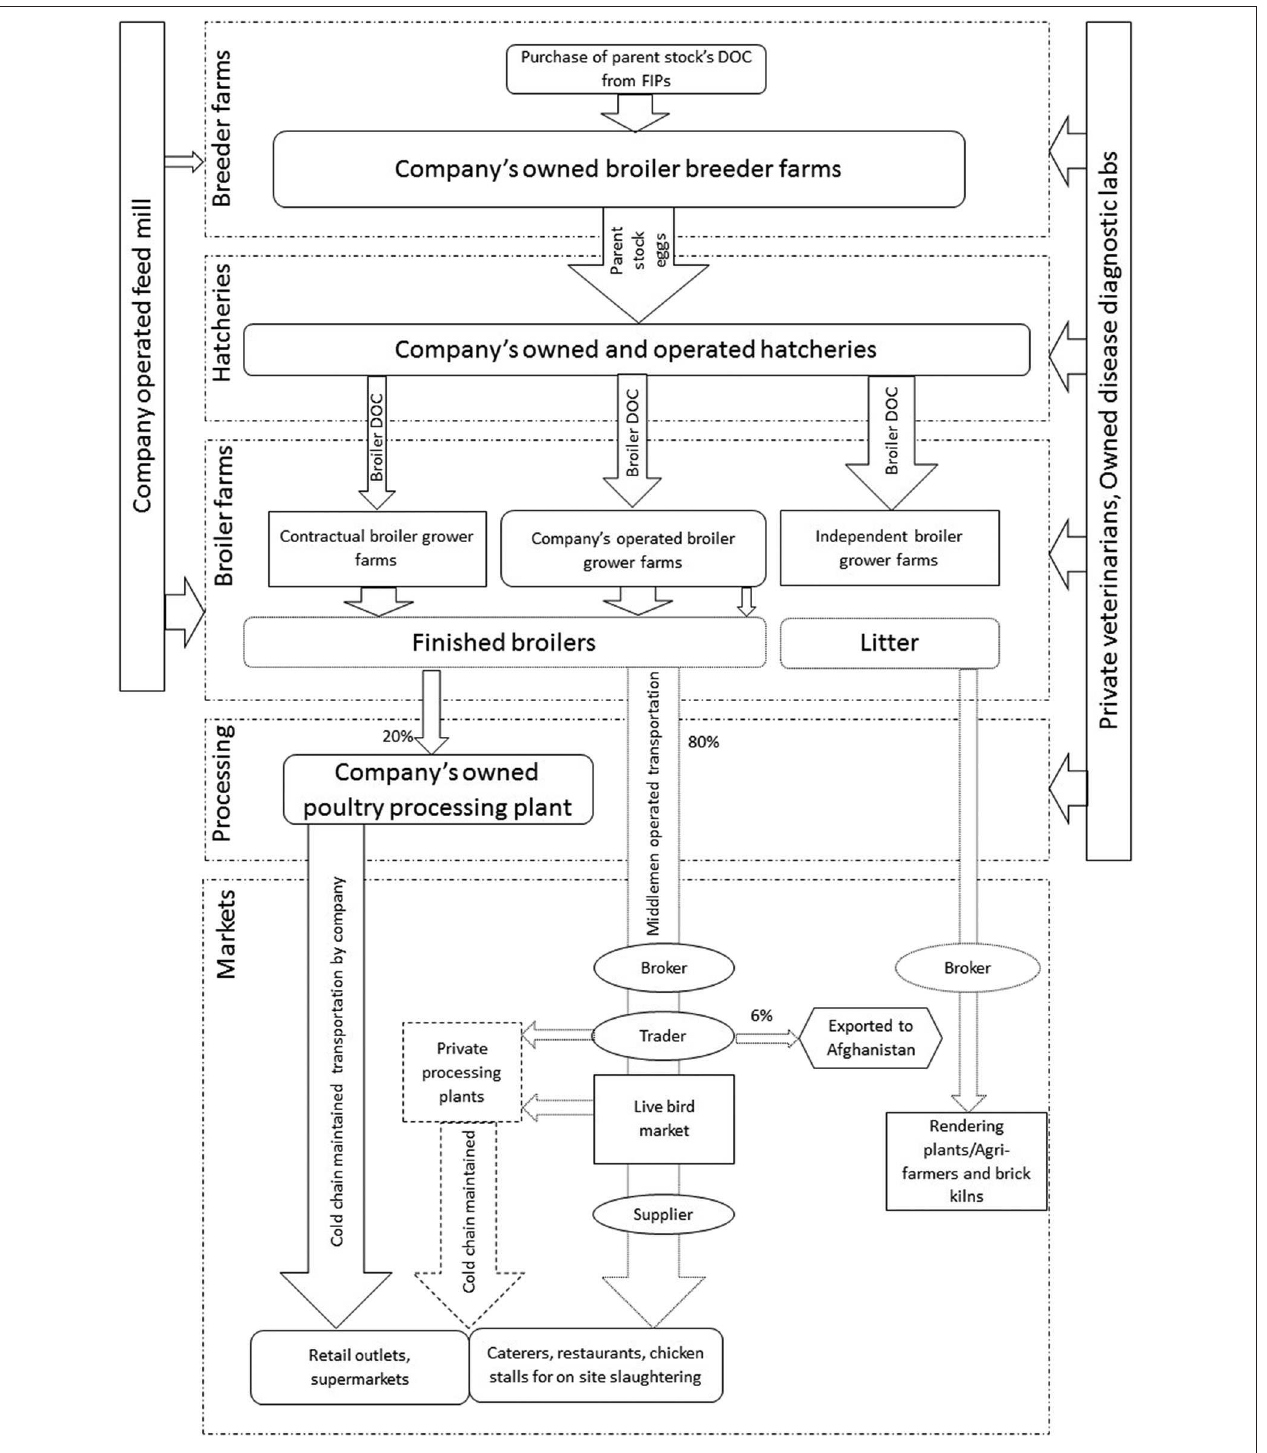
FIGURE 4 | Map of partially-integrated broiler production system with distribution chains and target markets. DOC indicates day old chicks, numbers in and around arrows and width of arrows indicates the market shares. Dotted lines show the parts of chains operated by the middlemen. FIPs refers to fully integrated production